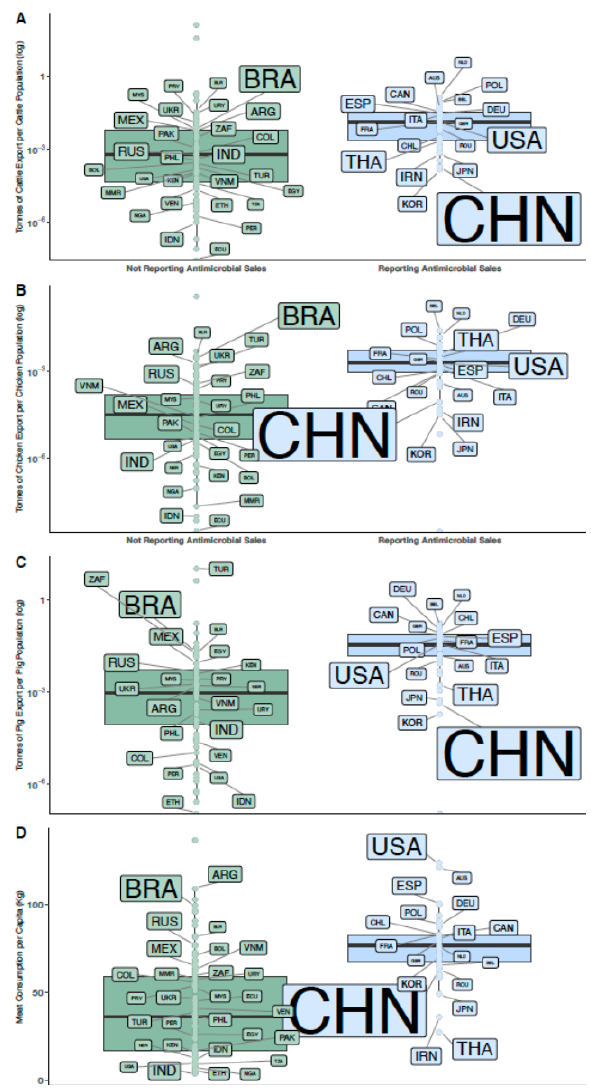
Figure 3. ( A ) Tonnes of cattle exports per cattle population in 2017 in countries reporting antimicrobial consumption (blue) vs. countries that did not report antimicrobial consumption (green); ( B ) Tonnes of chicken exports per chicken population in 2017 in countries reporting antimicrobial consumption (blue) vs. countries that did not report antimicrobial consumption (green); ( C ) Tonnes of pig exports per cattle population in 2017 in countries reporting antimicrobial consumption (blue) vs. countries that did not report antimicrobial consumption (green); ( D ) Meat consumption per capita (in kg) for countries that did and did not report veterinary antimicrobial sales data in 2017. Labels on all boxplots refer to the country’s ISO3 country codes. Size of the ISO3 code is proportional to the amounts of